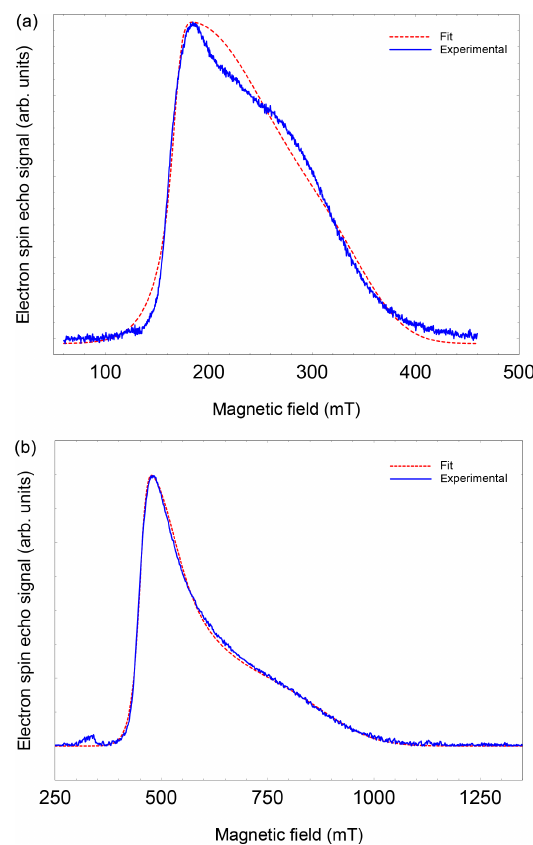
Figure A2. FSE spectra of NO@C60-OH3 ( T = 5K) with best fits. (a) S-band (3.5GHz, 10mM/CS 2 ). (b) X-band (9.7GHz, 2.5 mM/CS 2 ).